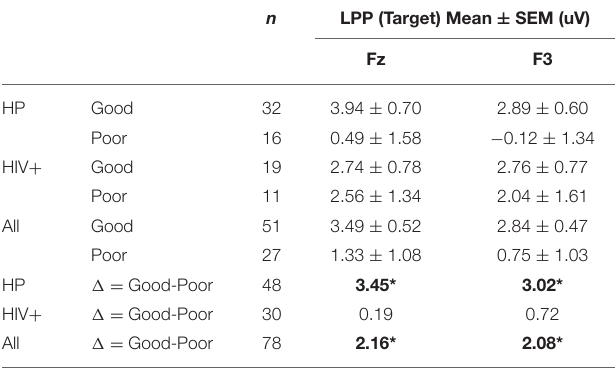
TABLE 3 | Average LPP amplitude for all groups and subgroups based on simulator driving performance.